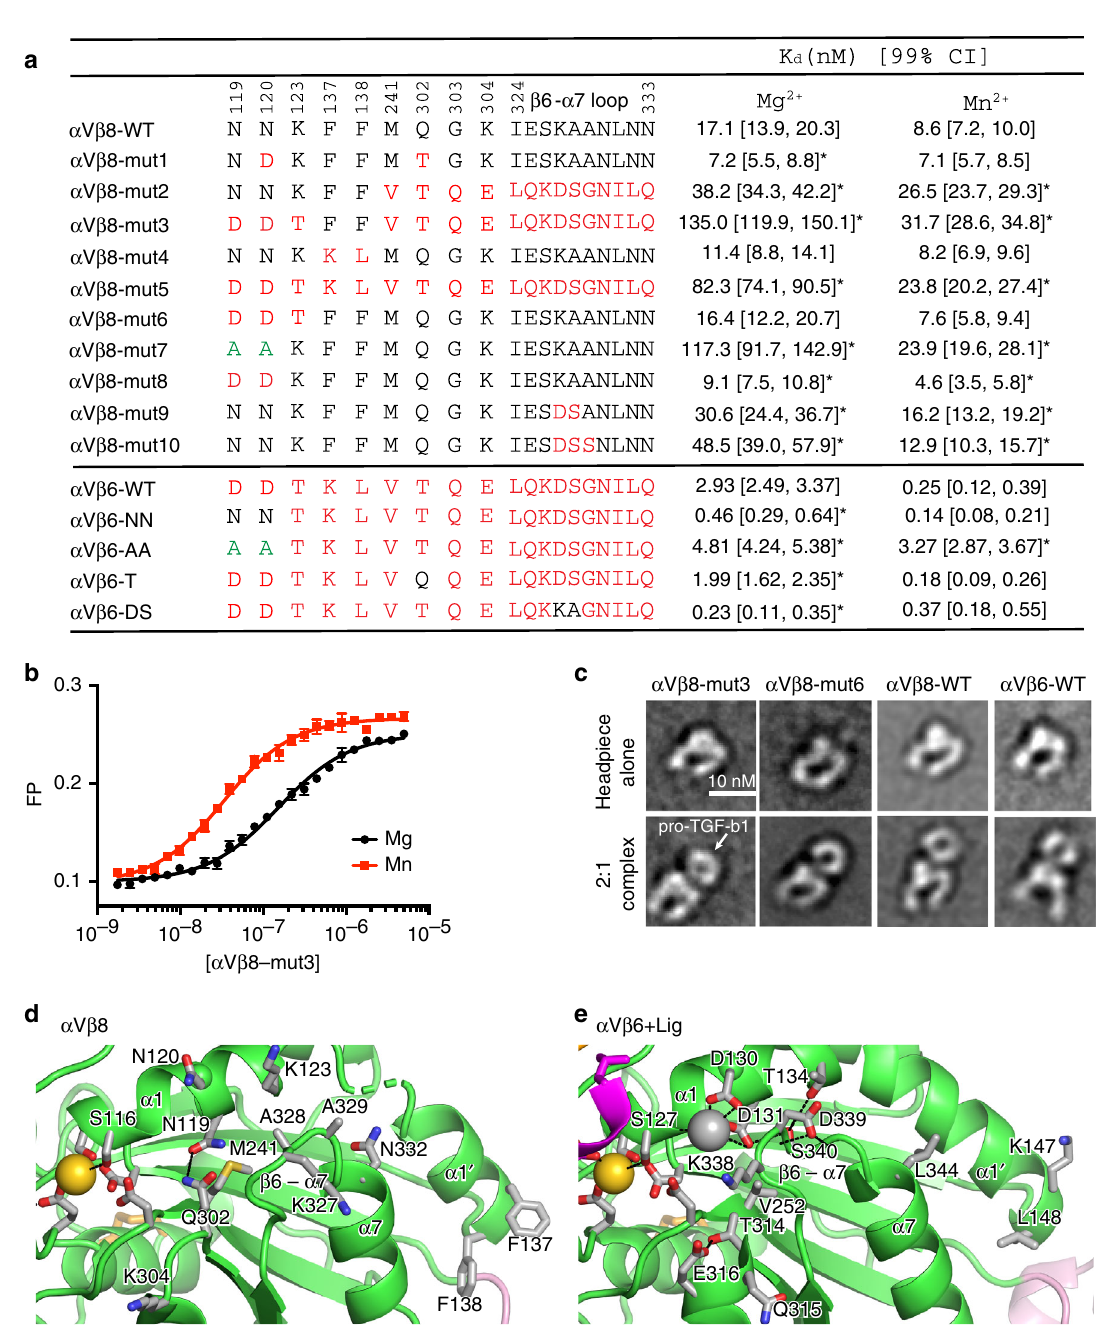
Fig. 7 Regulation of ligand-binding af fi nity by atypical and typical residues in α V β 8 and α V β 6. a Mutations corresponding to sequence exchanges between α V β 8 (black) and α V β 6 (red) and effect on af fi nity for FITC-labeled TGF- β 3 ligand peptide (GRGDLGRLKK) in presence of Mg 2 + and Mn 2 + . K con fi dence interval] values were determined by fl uorescence polarization and fi ts using the NonLinearModelFit function of Mathematica (Wolfram, Champaign, IL) of all data from measurements in triplicate of two different experiments done in different months. As in statistical models for determining p values, the fi t assumes that errors are independent and normally distributed. The reported fi t minimizes the sum of the squared errors. If two values have 99% con fi dence intervals that do not overlap, then the two values by de fi nition have <1% chance of being different by chance alone, that is, the p value is <0.01. Therefore, mutant K D values with con fi dence intervals that do not overlap with those of WT are signi fi cantly different ( p < 0.01) and are asterisked. b Representative fl uorescence polarization (FP) of α V β 8-mut3 from one triplicate experiment (average± s.d) with fi t (line). Source data for a , b are provided as a Source Data fi le. c Representative negative stain class averages of mutant or WT integrin headpieces alone (upper panels) or complexed with pro-TGF- β 1. Representative 2:1 pro-TGF- β 1:integrin class averages are shown. The WT integrin class averages shown for comparison are previously published 14 . d , e Residues in regions of β I domain allostery with unusual properties in α V β 8 ( d ) are compared to counterparts in α V β 6 ( e